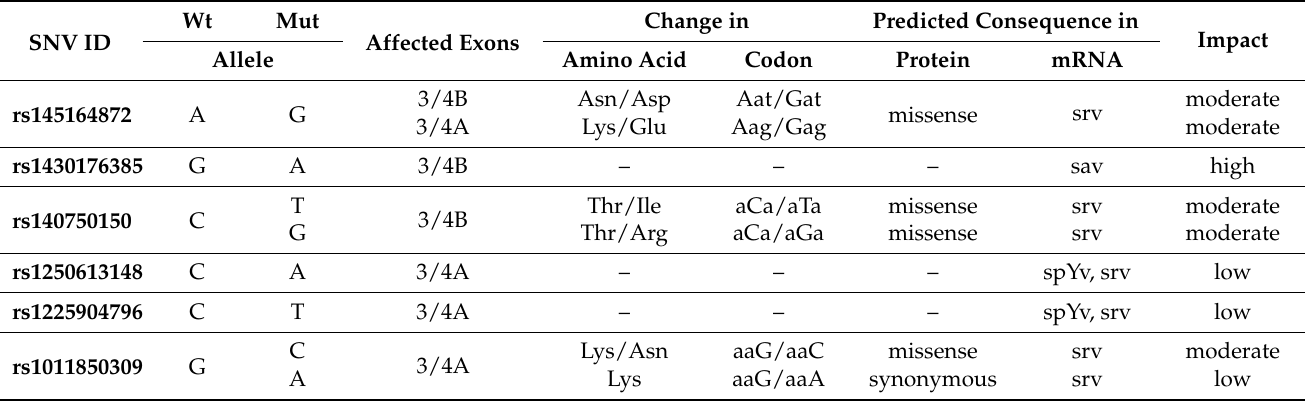
Table 1. Location of SNVs affecting the AB donor site or the A or B acceptor site in the SCD5 gene and their effect predicted by the VEP program. The exact sequence context is provided in Figure